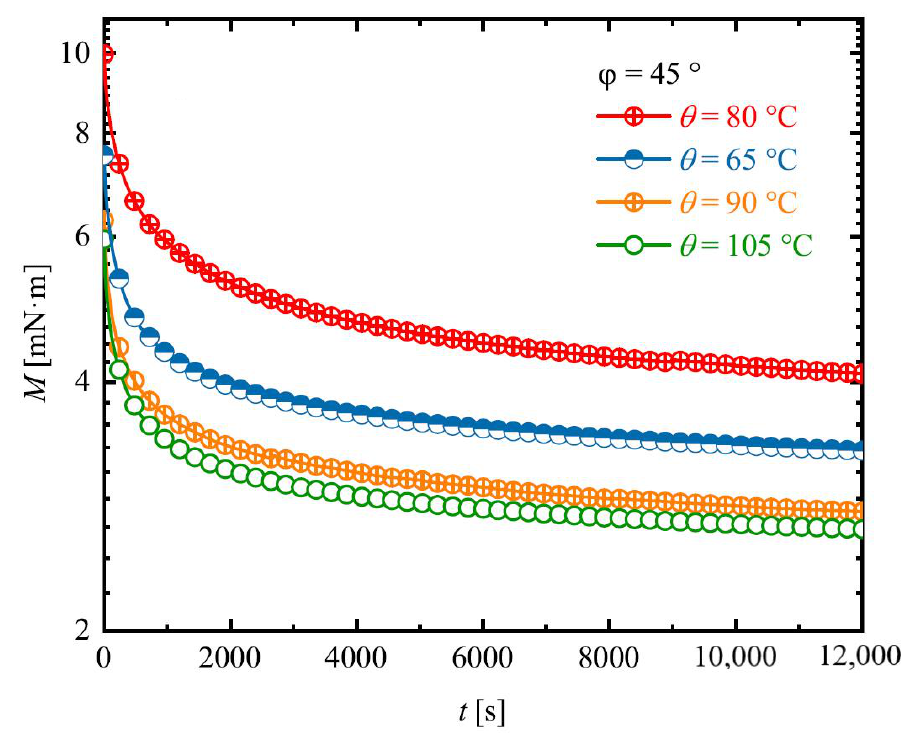
Figure 6. Stress relaxtion experiments for Estane deformed up to ϕ = 45 ◦ at different temperatures as torque-time ( M − t )